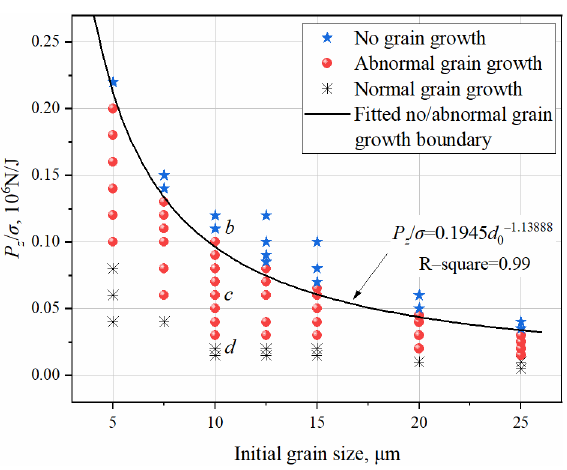
Figure 10. Various grain growth regimes as functions of initial grain size and pinning force.